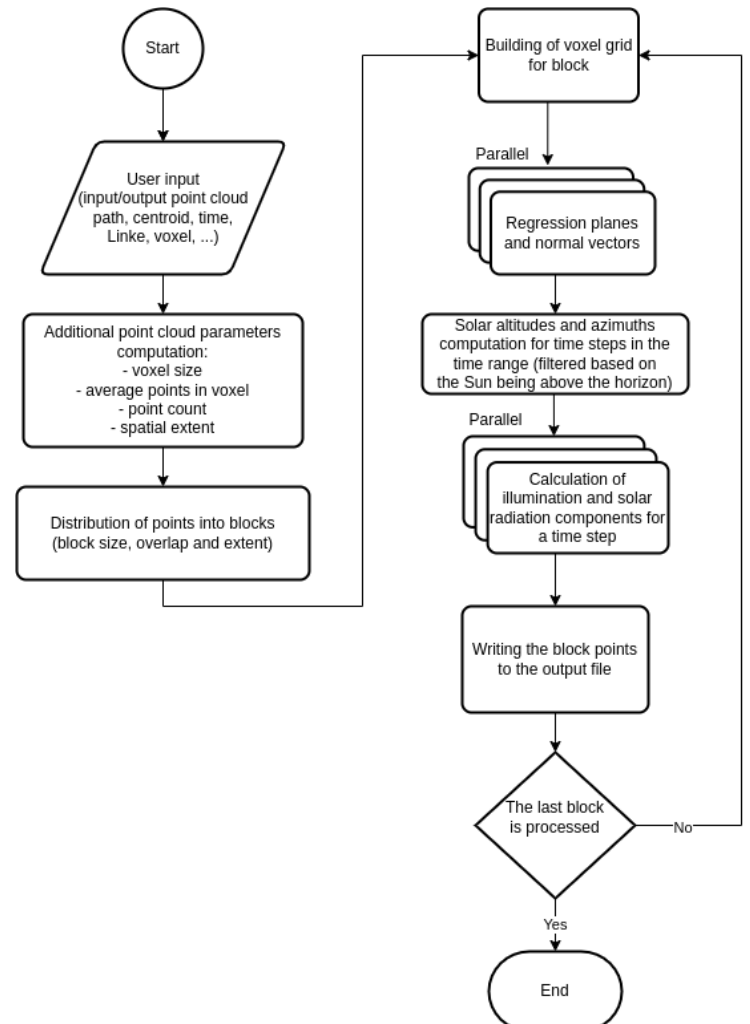
Figure 2. The flow chart of the main pcsrt